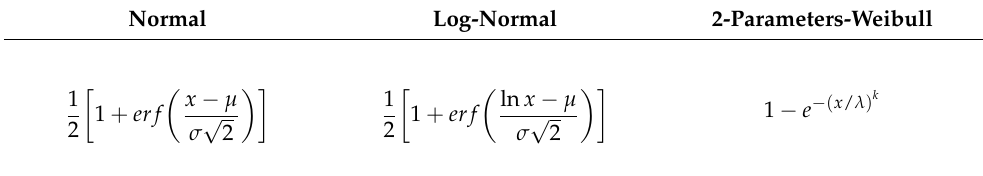
Table 1. Density and MOE statistics of the two-dimensional larch lumber types. Normal Log-Normal 2-Parameters-Weibull